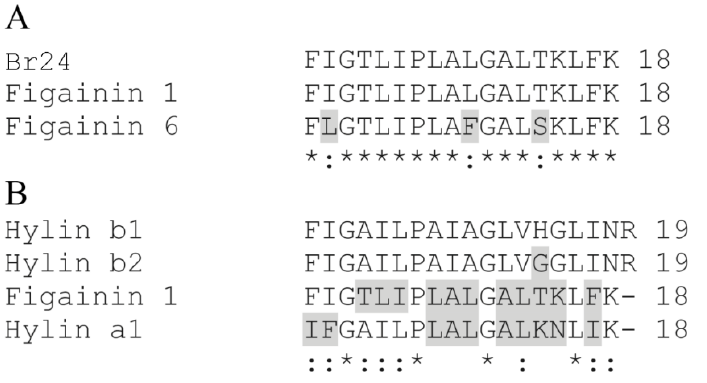
Figure 3. ( A ) Sequence alignment of the antibacterial peptide (isolated from Br24 fraction) with other putative antimicrobial peptides from B. raniceps [25] leading to the identification of Figainin 1, and ( B ) sequence alignment of Figainin 1 with Hylins (antimicrobial peptides isolated from other species in Boana genus). Di ff erences of amino acids are highlighted in gray, ‘*’ indicates identical amino acids and ‘:’ indicates conservative substitutions.